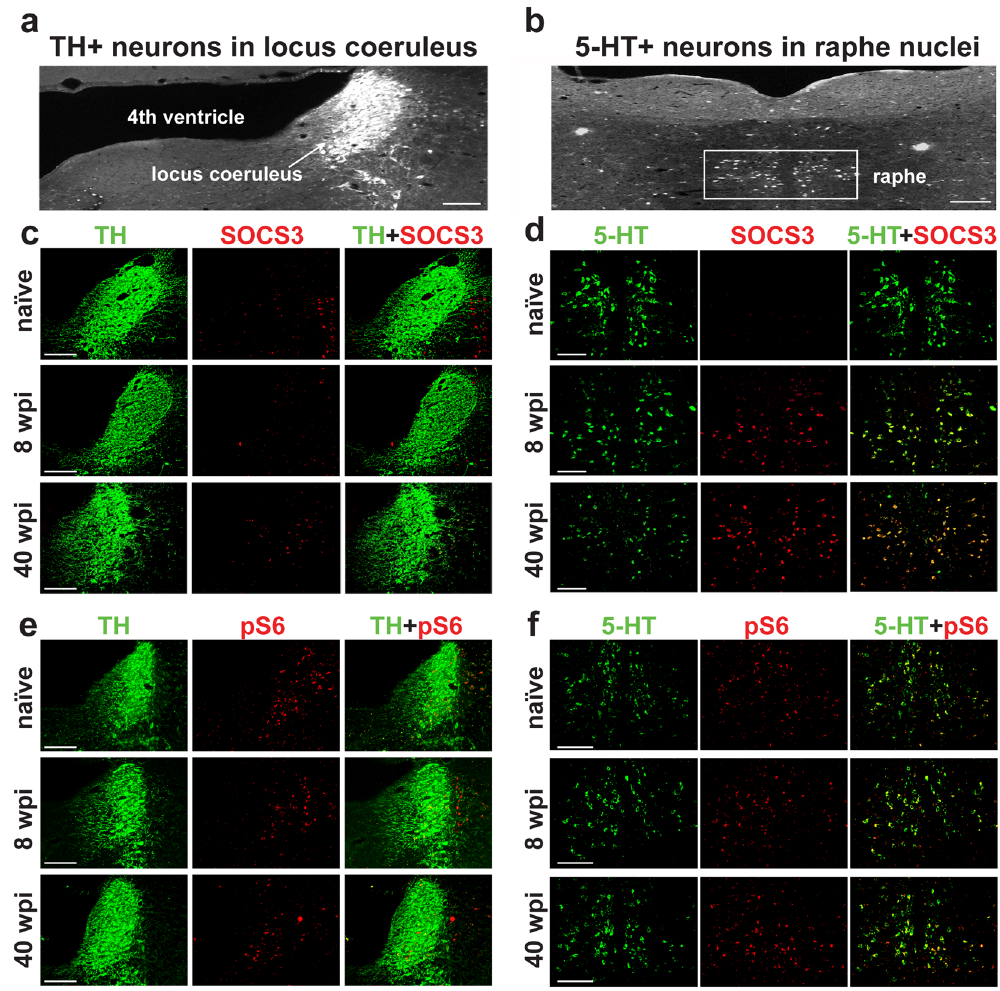
Figure 5. The raphe, but not the locus coeruleus, increases SOCS3 expression following chronic SCI. ( a ) Fluorescent image of the brainstem with TH staining illuminating the locus coeruleus. ( b ) Fluorescent image of the brainstem with 5-HT staining illuminating the raphe. ( c ) Fluorescent images of the locus coeruleus with TH (green) and SOCS3 (red) staining in naïve cord, eight weeks post SCI, or 40 weeks post SCI treated with PNG + aFGF + ChABC. ( d ) Fluorescent images of the raphe with 5-HT (green) and SOCS3 (red) staining in naïve cord, eight weeks post SCI, or 40 weeks post SCI treated with PNG + aFGF + ChABC. ( e ) Fluorescent images of the locus coeruleus with TH (green) and pS6 (red) staining in naïve cord, eight weeks post SCI, or 40 weeks post SCI treated with PNG + aFGF + ChABC. ( f ) Fluorescent images of the raphe with 5-HT (green) and pS6 (red) staining in naïve cord, eight weeks post SCI, or 40 weeks post SCI treated with PNG + aFGF + ChABC. Scale bar, 100 µ